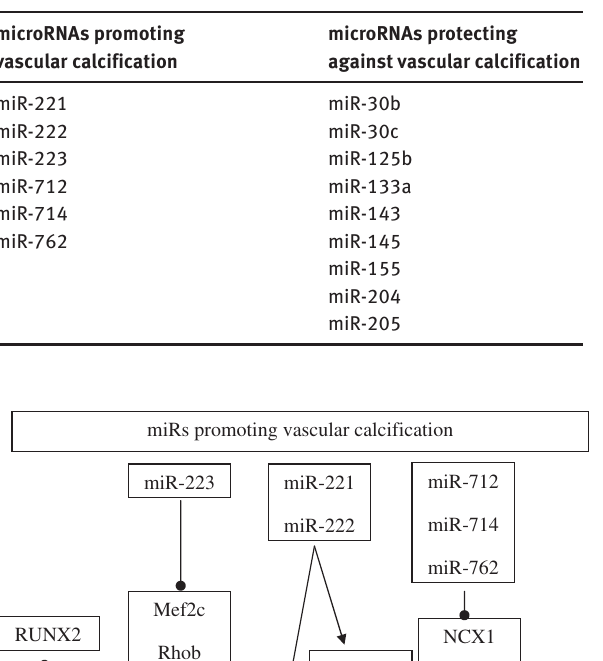
Elevated inorganic phosphate concentrations are asso- ciated with increased risk for vascular calcification and also increase the expression of miR-223, suggesting a role of the latter miR in vascular calcification (12). Physiologi- cally, miR-223 is involved in the bone formation process.